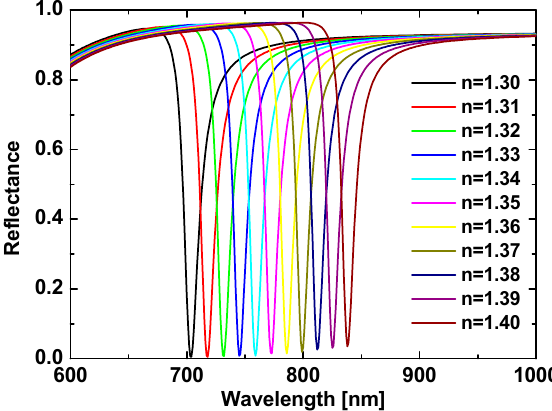
Figure 5. TM reflection spectra for AMDW structure and for several analyte RIs, all with a 45° angle of incidence.